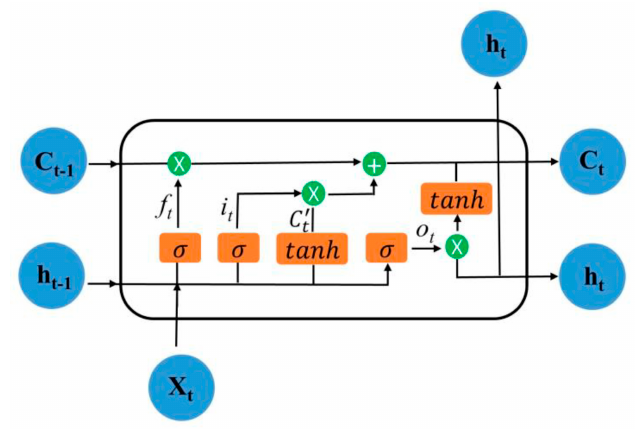
Figure 4. Long short-term memory network structure.